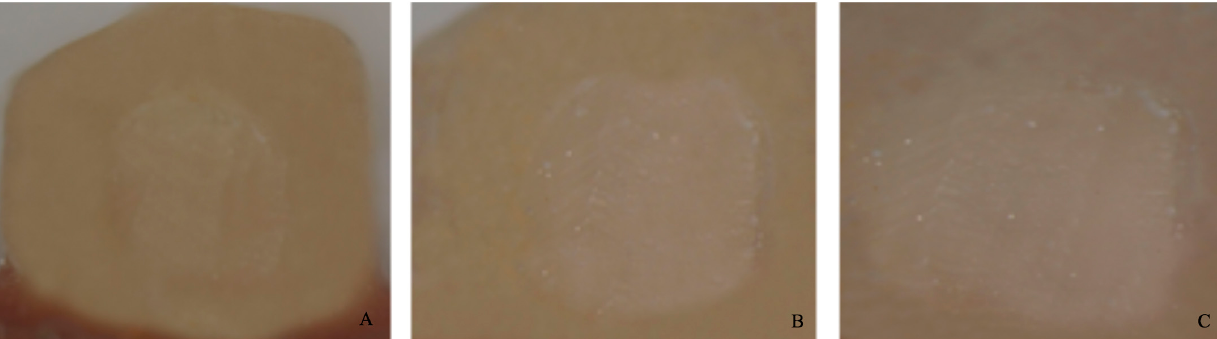
Figure 4. Score 0. ( A ) Magnification: 10 × 1; ( B ) Magnification: 10 × 1.6; ( C ) Magnification: 10 × 2.5.